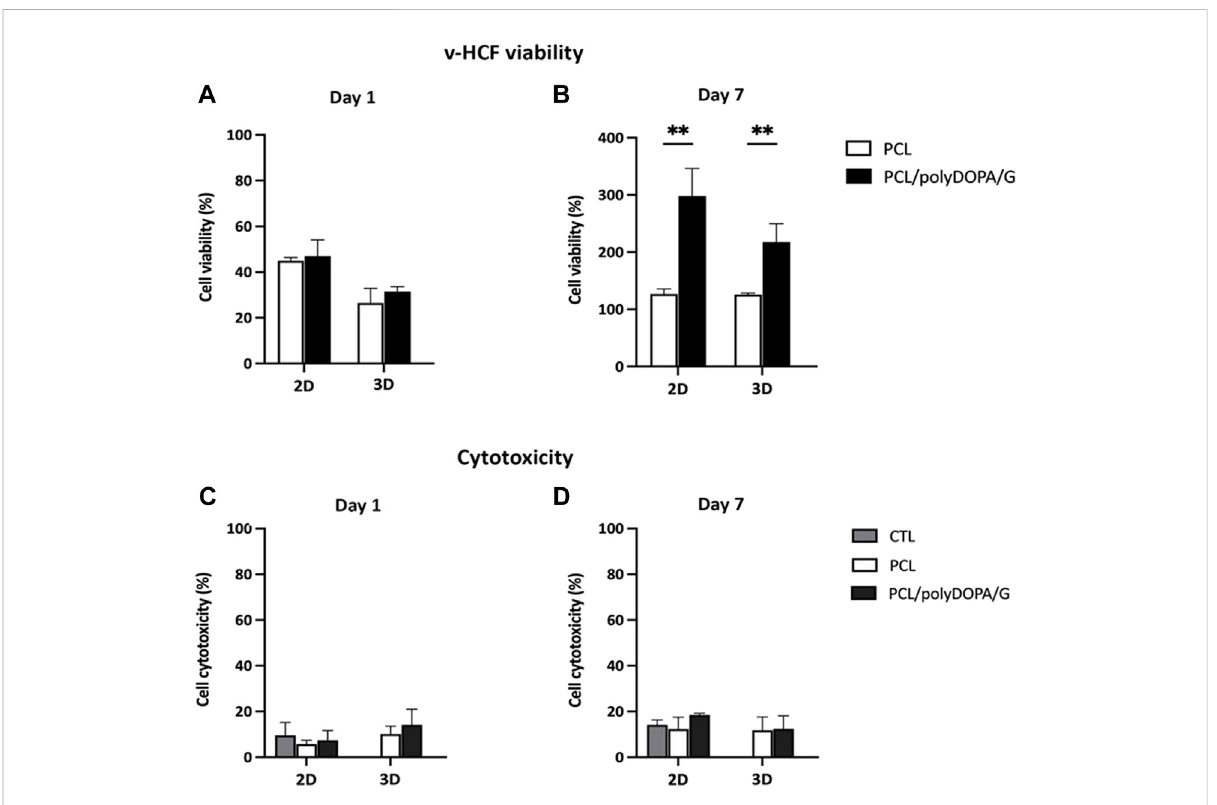
The deposited extracellular matrix was imaged in Figure 8C: signal acquired in the green channel (550 +/ − 44 nm) integrated the two-photon excited fl uorescence response of both labeling fl uorophores (Alexa Fluor 555 and Alexa Fluor 488), precluding the distinction of the two co-stained proteins (i.e., Collagen I and Collagen IV). The blue signal was due to a weak auto fl uorescence from both the PCL and residual DAPI stained-cell nuclei. Green fl uorescent signal associated with Collagen I and Collagen IV deposition was detected both on the external surface and inner structure of 3D scaffolds (high value of Z-depth ~300 μ m). Furthermore, below the more external PCL fi lament, residual fi broblasts were observed. The presence of elongated residual fi broblasts was more evident from a supplementary movie that reconstructed the 3D volume in real-time (Supplementary Movie S2). The deposition of a dense ECM on scaffold fi laments probably hindered complete v-HCFs removal during decellularization in static